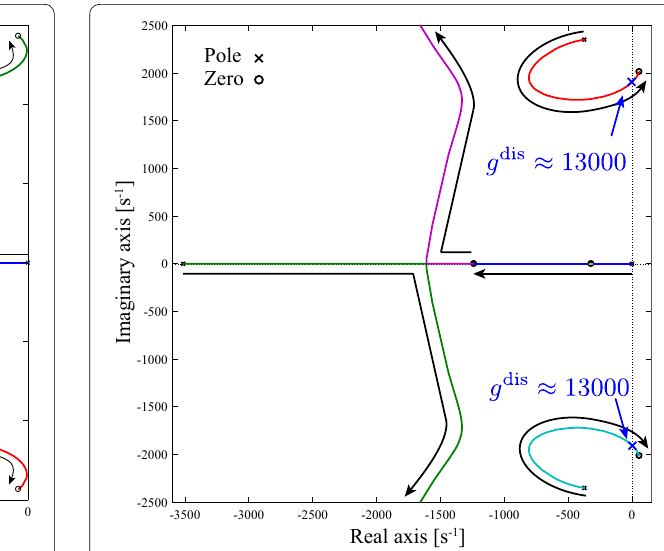
Fig. 10 Root locus for variation of sensor and RTOB information integration bandwidth g I